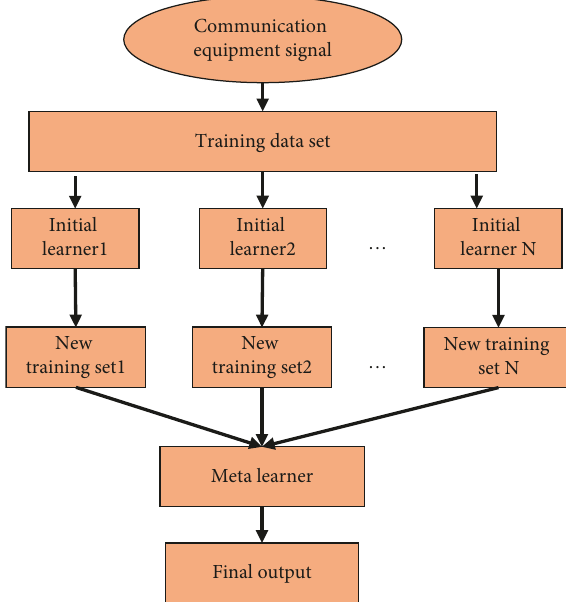
Figure 4: Stacking integration model framework